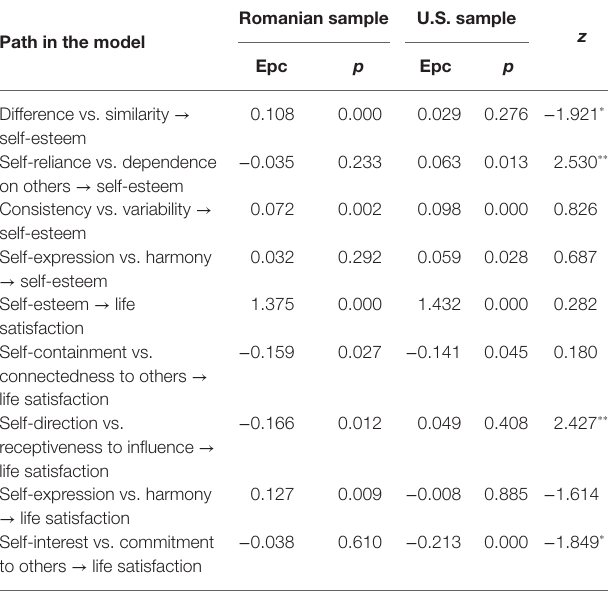
TABLE 9 | Differences in the paths of the model between the two cultural samples in Study 2. Romanian sample U.S. Path in the model